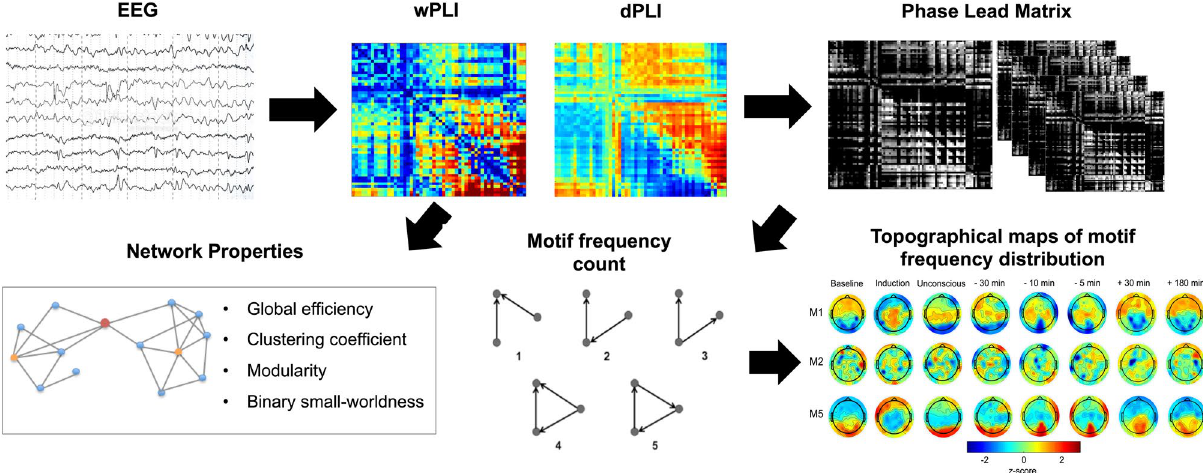
Figure 6. Pipeline for extracting network properties and motifs EEG time series. Each 5-min EEG epoch was used to construct a wPLI and dPLI matrix. Network properties were then calculated based on the wPLI matrix, while the dPLI matrix was used to create a phase-lead matrix, which set all non-phase-leading values to 0 (black), and normalized the remaining non-zero values between 0 and 1. Motifs were then extracted from the phase lead matrix, and their frequency (i.e. frequency of participation of each node in each of the possible motifs) and topology (i.e. topological distribution of participating nodes in each motif) were calculated. EEG: electroencephalography; wPLI: weighted phase lag index; dPLI: directed phase lag